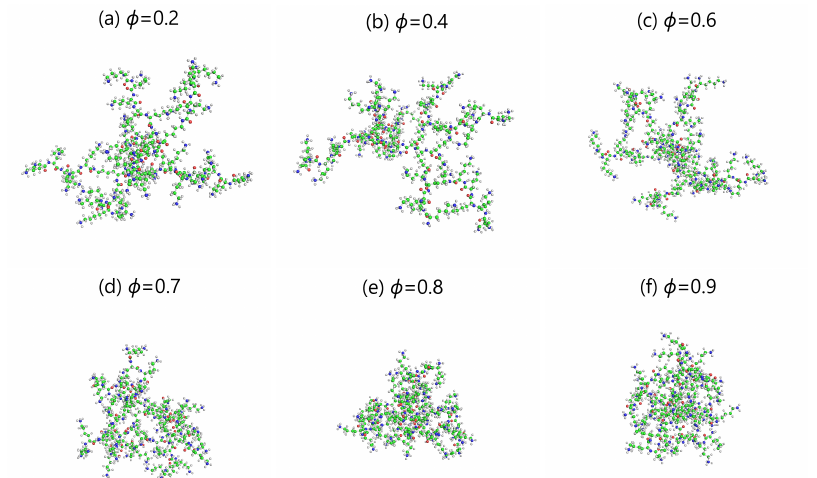
Figure 1. The snapshots of DGL1 at different methanol fractions φ . Upper pictures from left to right: 0.2, 0.4 and 0.6; bottom pictures from left to right: φ = 0.7, 0.8, 0.9.